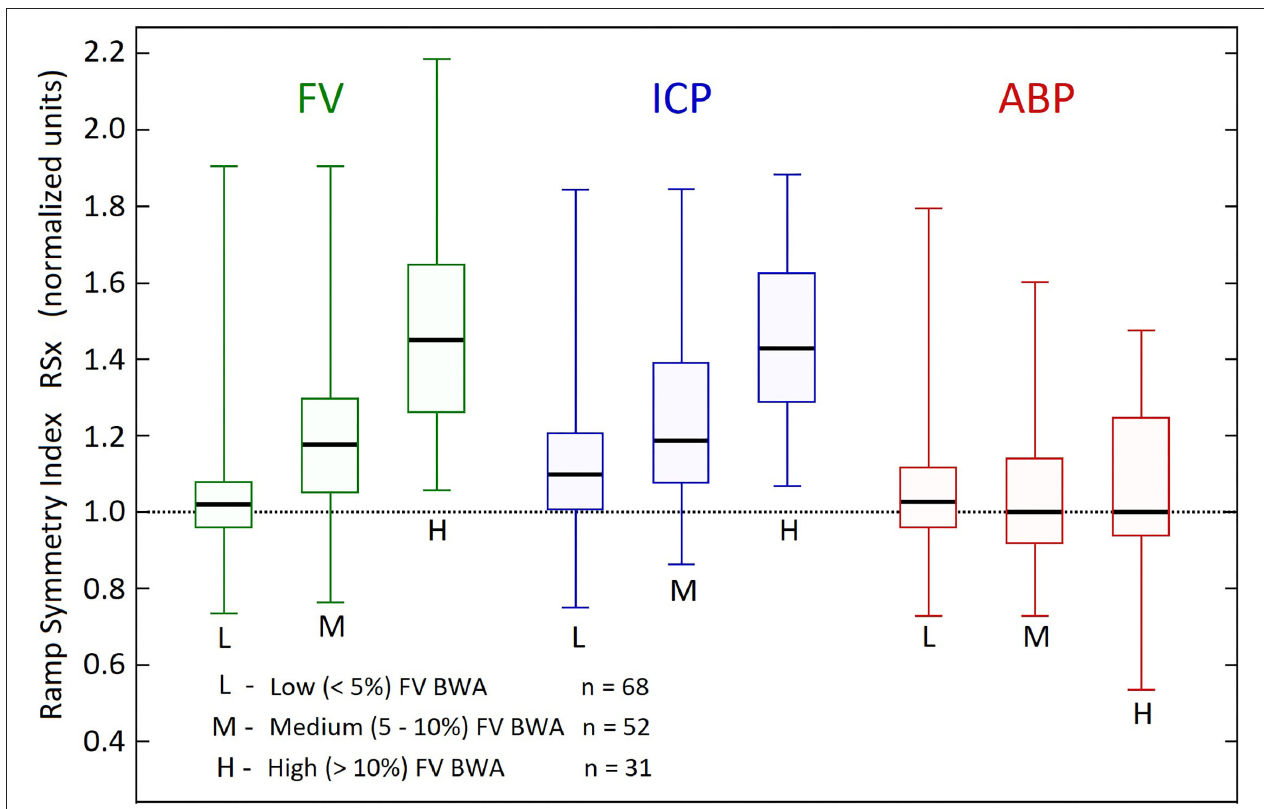
FIGURE 4 | Comparison of ramp symmetry index across B wave activity groups. Box plots of the distribution of ramp symmetry indices (RSx) in the three B wave activity (BWA) groups according to B wave amplitude, related to arterial blood pressure (ABP), intracranial pressure (ICP), middle cerebral artery flow velocities (FV). The Boxes represent upper and lower quartiles, with the thick horizontal lines within the boxes, showing the medians. The vertical lines with the top and bottom caps, represent maximum and minimum RSx values for each variable and Group. The mean RSx in the High BWA group (FV mean = 1.49, median = 1.45) and also the FV and ICP for high and medium groups significantly exceeded unity ( p < 0.001, 2 tailed t test). The ABP in the both the high and the medium BWA groups were not significantly different from 1. ( p = 0.3 and p = 0.07, two tailed t